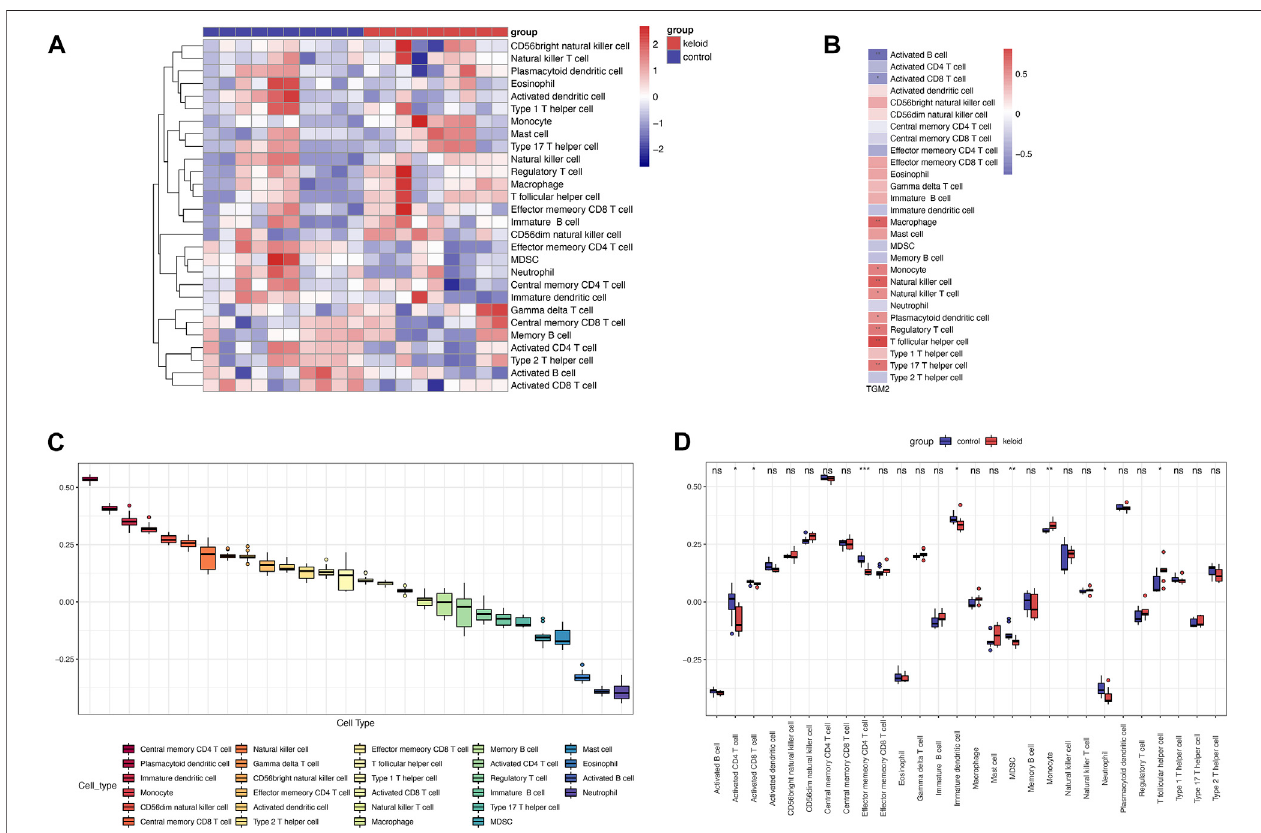
FIGURE4| Evaluation and visualizationofimmunecell in fi ltration. (A) Heatmap ofimmune cellsinkeloidand controlgroupsviasingle-samplegenesetenrichment analysisin GSE145725 dataset ( n =19). (B) CorrelationanalysisofTGM2 expression withimmune cellin fi ltrationin theGSE145725 dataset. (C) Rankingofimmunecell scoresintheGSE145725dataset. (D) VariationofimmunecellscoresbetweenkeloidandcontrolgroupsintheGSE145725dataset.* p < 0.05;** p < 0.01;*** p < 0.001; **** p < 0.0001. ns, not signi fi